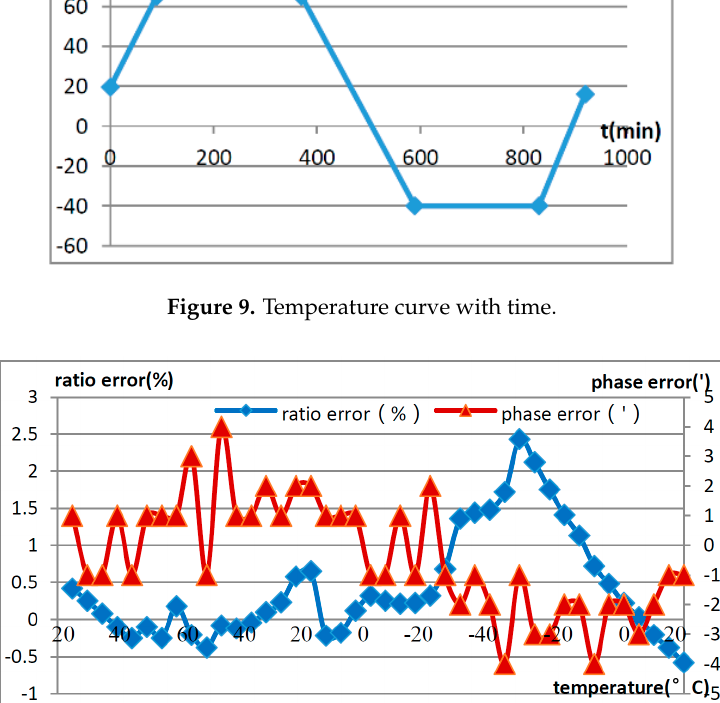
Figure 10. Temperature characteristic of OVTs in the laboratory.